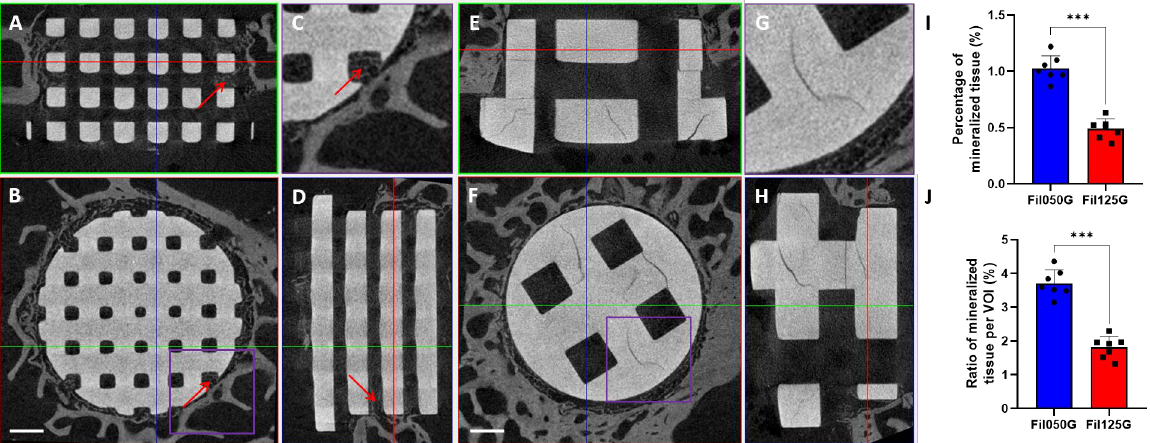
Figure 6. Illustration ( A – H ) and quantification ( I , J ) of µCT scanning for Fil050G- and Fil125G-related samples after 10 days of implantation. ( A – D ) Illustration of µCT scanning of Fil050G-related samples with side view ( A , D ), upper view ( B ), and magnification from the upper view ( C ). Illustration/representation of µCT scanning of Fil125G-related samples with side view ( E , H ), upper view ( F ), and a magnification from the upper view ( H ). Quantification of the percentage of mineralized tissue ( I ) and the ratio of mineralized tissue per volume of interest ( J ). Red arrows indicate mineralized tissue. Scale bar for ( A – H ) = 1 mm. p -values are indicated as follow; *** p < 0.001.